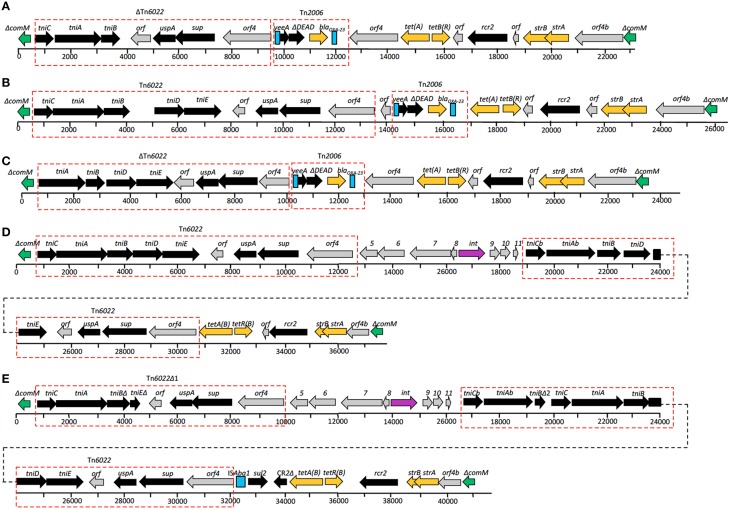
Structures of resistance islands present in A. baumannii AC12, AC30, and AC29 as compared to similar islands in A. baumannii MDR-ZJ and MDR-TJ. (A) Structure of resistance island ACRI12-1 present in A. baumannii AC12. ΔTn6022, Tn6022, and Tn2006 are indicated in the red dotted-line box. Directions of genes and ORFs are indicated by arrows above the central thick line and the names are as given above. Green boxes represent truncated ΔcomM, turquoise blue boxes represent insertion element, ISAba1, and orange boxes represent genes conferring antibiotic resistance. Numbered boxes in gray represent genes encoding for hypothetical proteins. Comparison between structures of (A) AC12-RI1, (B) AC30-RI1, (C) AC29-RI1, (D) AbaR22, and (E) RIMDR−TJ, revealed similarities in the islands, as indicated by the same colors and red dotted-line box.